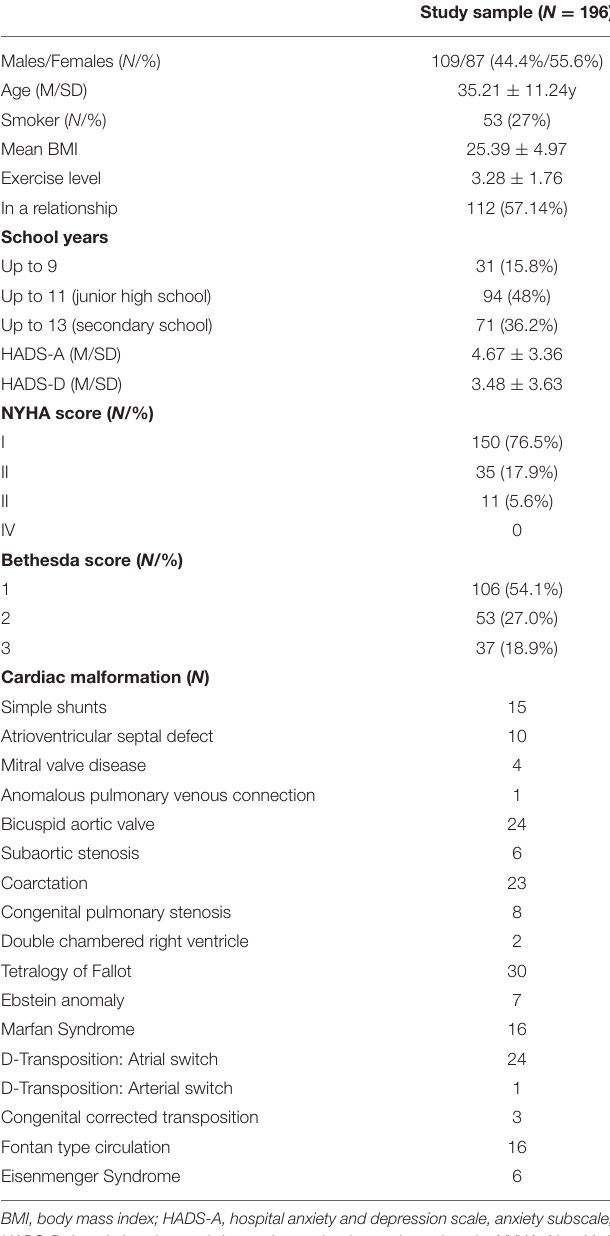
TABLE 1 | Descriptive statistics regarding socio-demographics, questionnaires, and type of cardiac malformation of the current